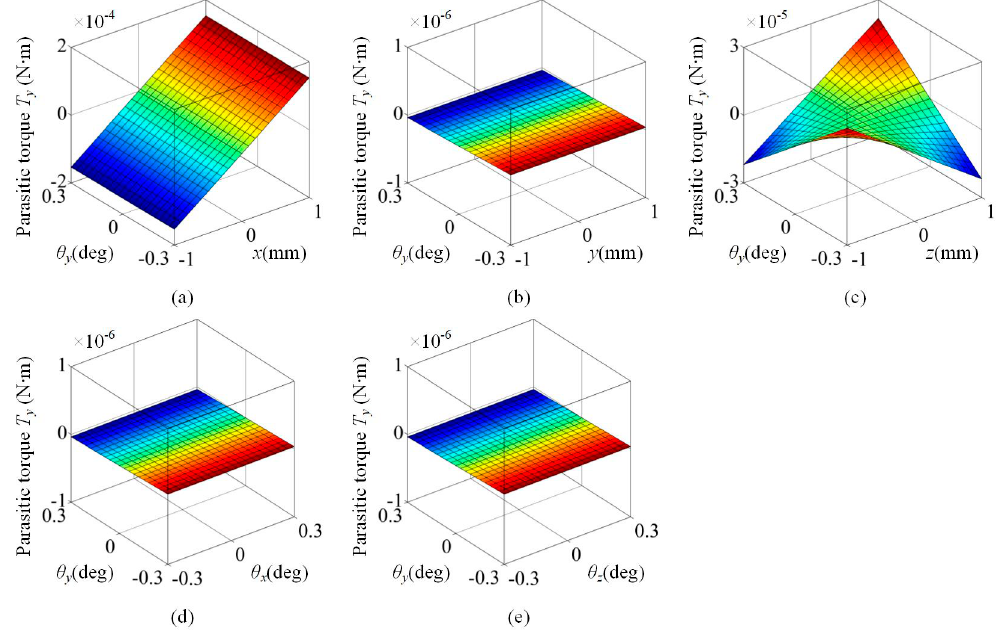
Figure 11. Parasitic torque T y characteristic of the HMF-VCA varied with the mover’s motion. ( a ) T y vs. θ y and x . ( b ) T y vs. θ y and y . ( c ) T y vs. θ y and z . ( d ) T y vs. θ y and θ x . ( e ) T y vs. θ y and θ z .